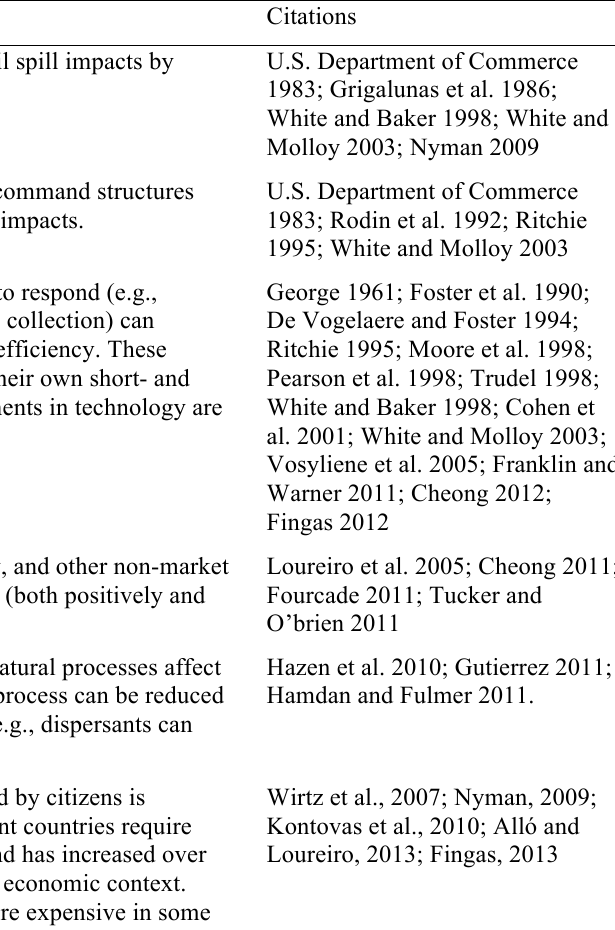
Table A1.2 Disaster management